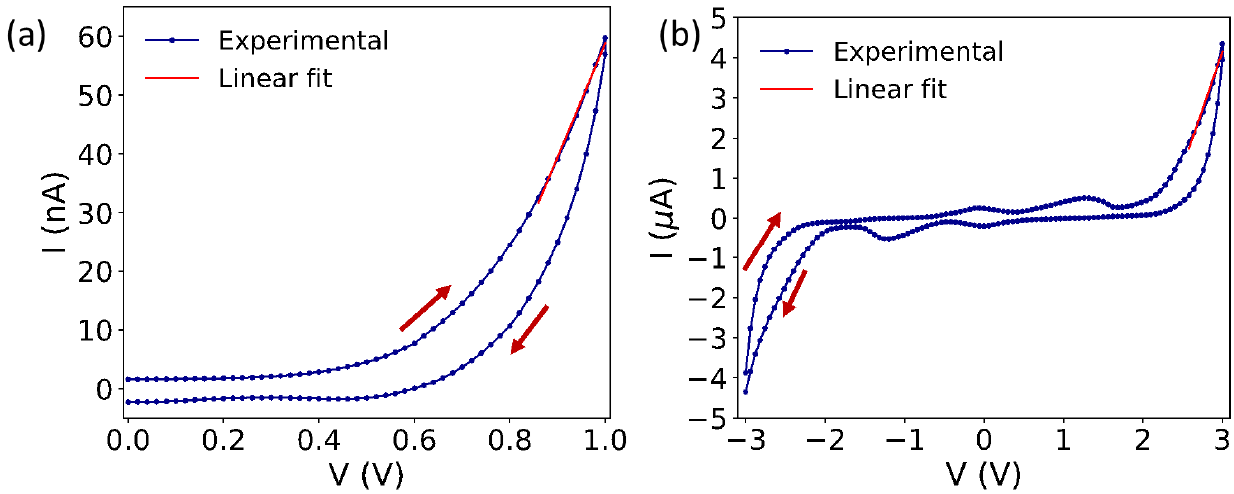
Figure 6. I-V plots of the BTBT onto Au IDEs in which the applied voltage swept from ( a ) 0 V to + 1 V, and ( b ) − 3 V to + 3 V. + 1 V, and ( b ) − 3 V to + 3